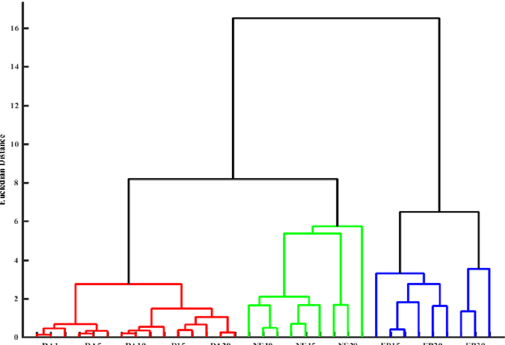
Figure 3. HCA dendrogram for catecholamine neurotransmitters. All the experiments were performed in triplicate. The concentration range of catecholamine neurotransmitters was 1–30 µ g mL − 1 .